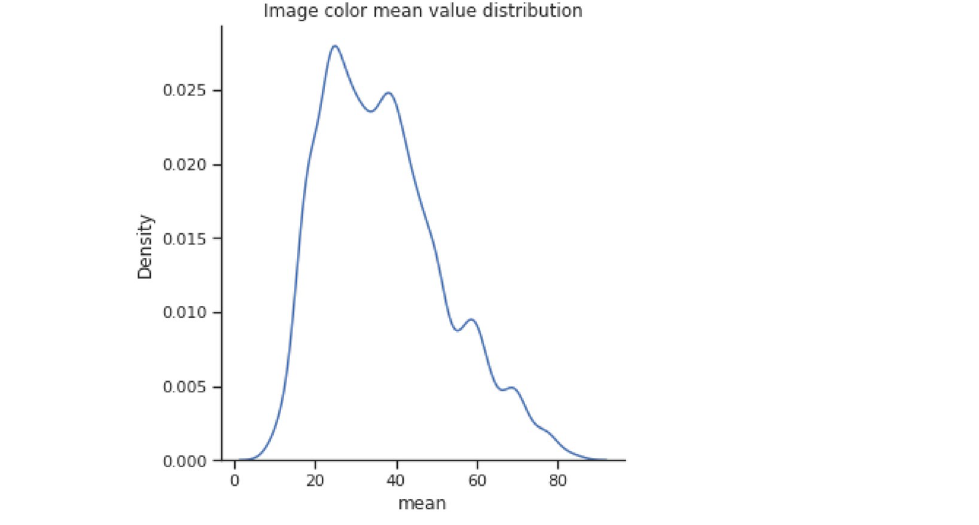
Figure 3. colour mean value distribution of images.